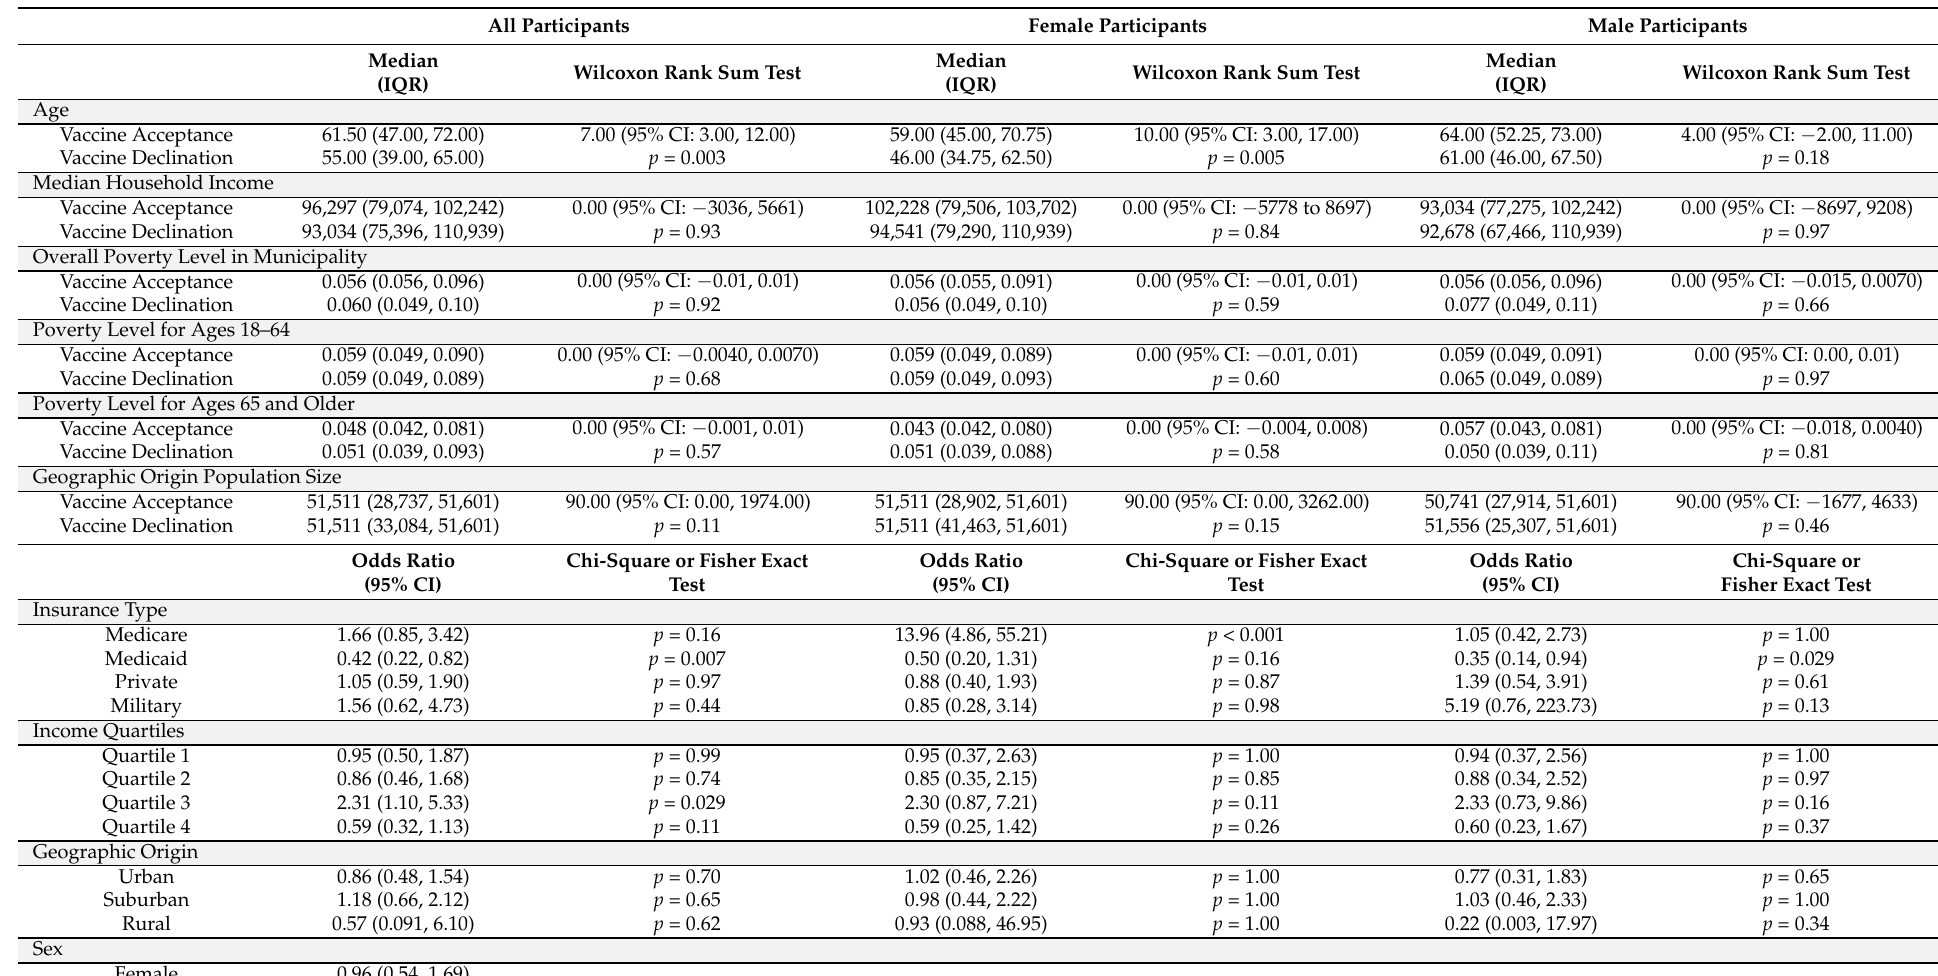
Table 4. Sociodemographic variables for all patients with neurological diseases and stratified by sex: crude odds ratios. All